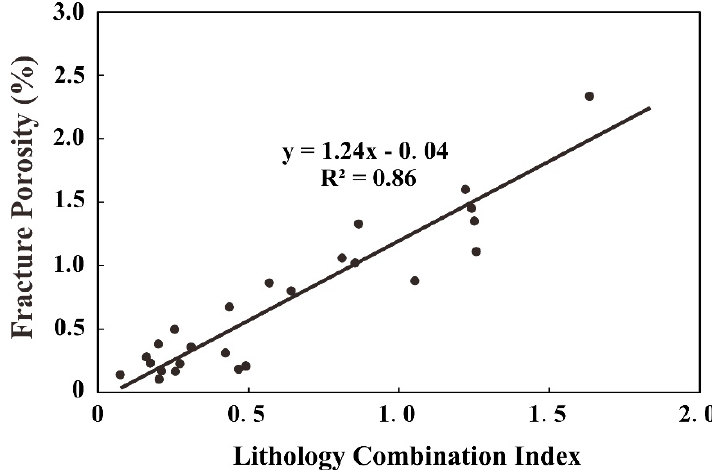
Figure 8. The relationship between lithology combination index (LCI) and fracture porosity.